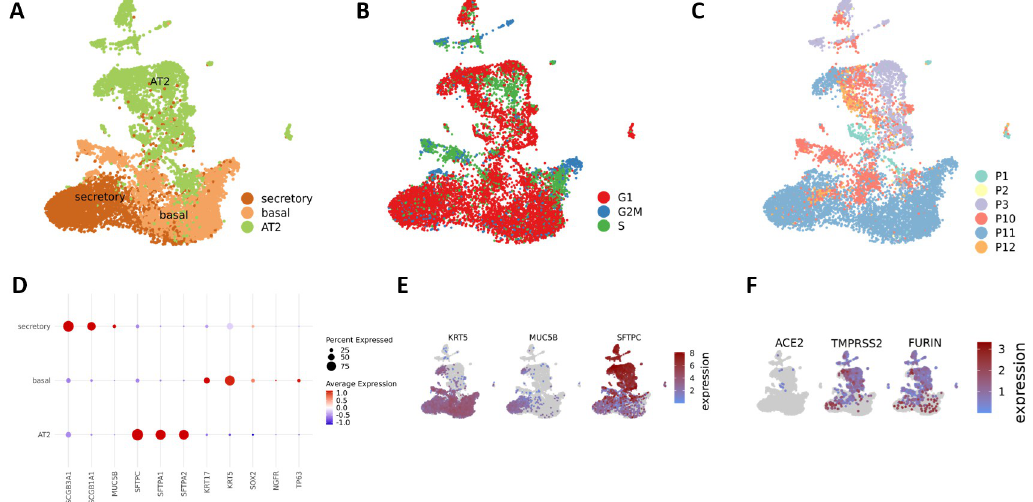
Fig 4. Single-cell RNA sequencing displays the proportion of three different cell types and SARS-CoV-2 host factors present in uninfected human alveolar-like organoids. UMAP embedding of human alveolar-like organoids (n = 6; P1-P3 and P10-P12) shows AT2, basal, and secretory cells present in the organoids (A). Cell cycle phase of each cell in either G2M, S or G1 phase (B) and individual donor composition (C) is displayed. The marker genes needed for cell type identification are shown (D and E) as well as the expression of the SARS-CoV-2 host factors ACE2 , TMPRSS2 , and FURIN (F).